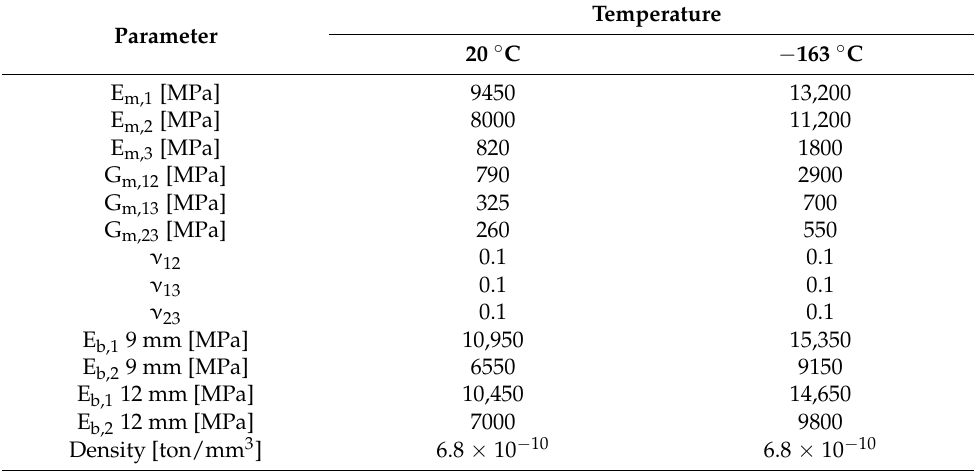
Figure 7. Peak values (ultimate structural response) and impulse values (shaded area).